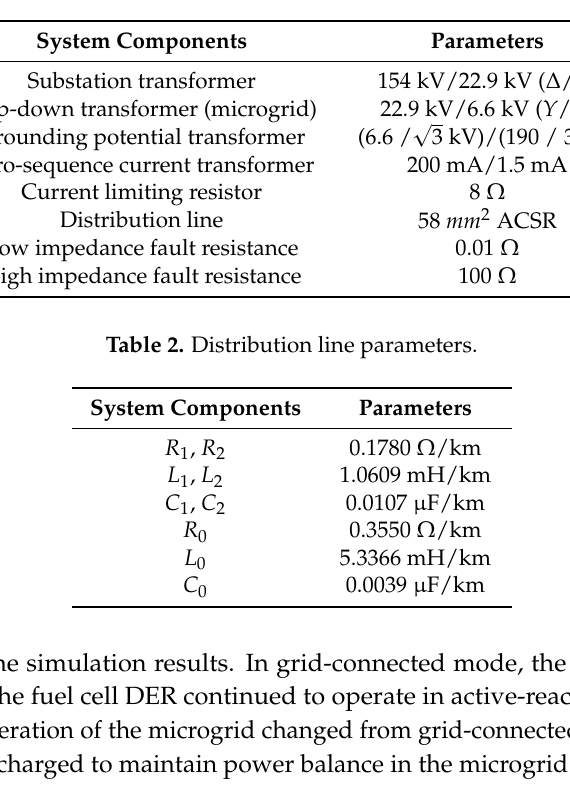
Table 1. System configuration.